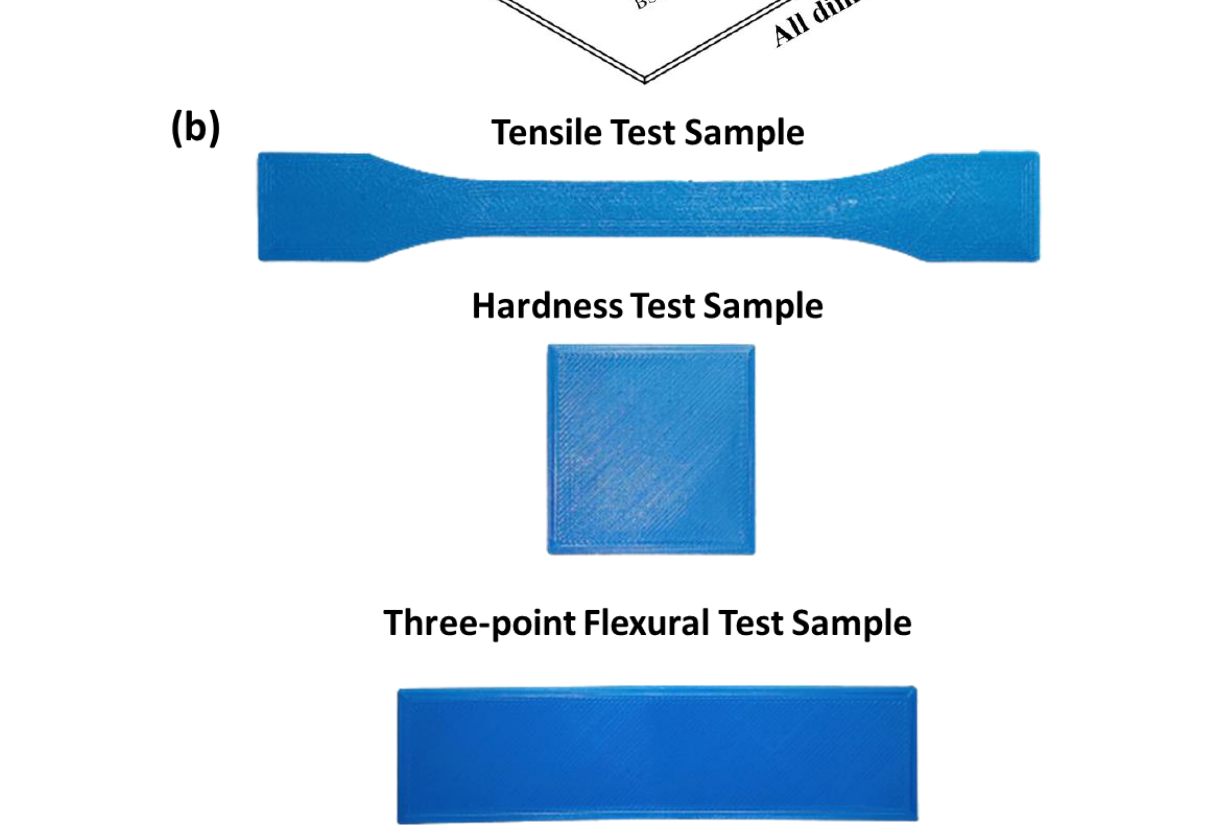
Figure 2. Manufacture of samples: ( a ) dimensions and build orientation; ( b ) tensile, hardness and three-point flexural testing samples.